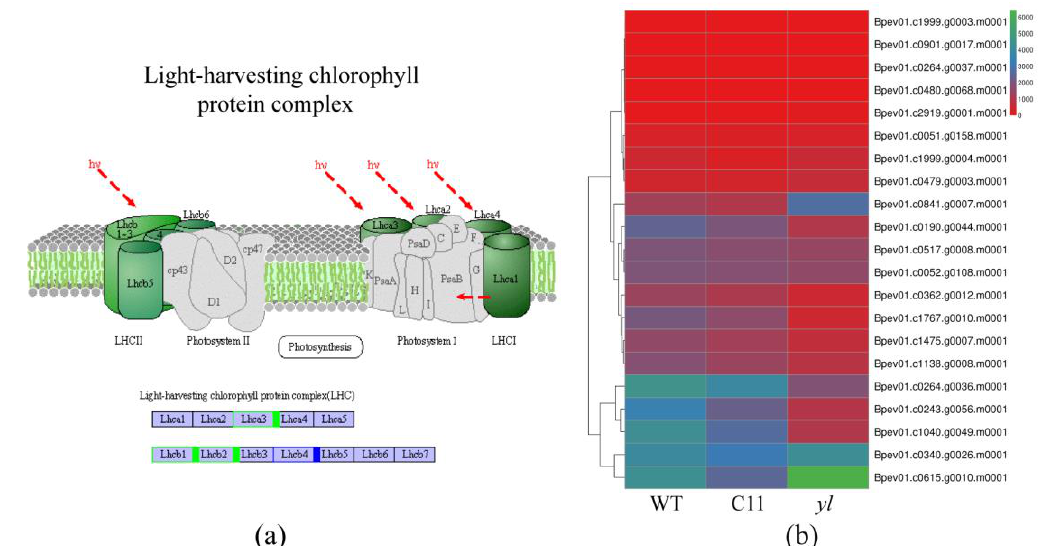
Figure 7. Expression pattern of genes involved in light-harvesting Chl complex in WT, C11, and yl . ( a ) DEGs in the pathway of light-harvesting Chl complex. Green box represents down-regulated genes. Blue box represents down-regulated and up-regulated genes. ( b ) Expression of all genes involved in light-harvesting Chl complex in WT, C11, and yl.